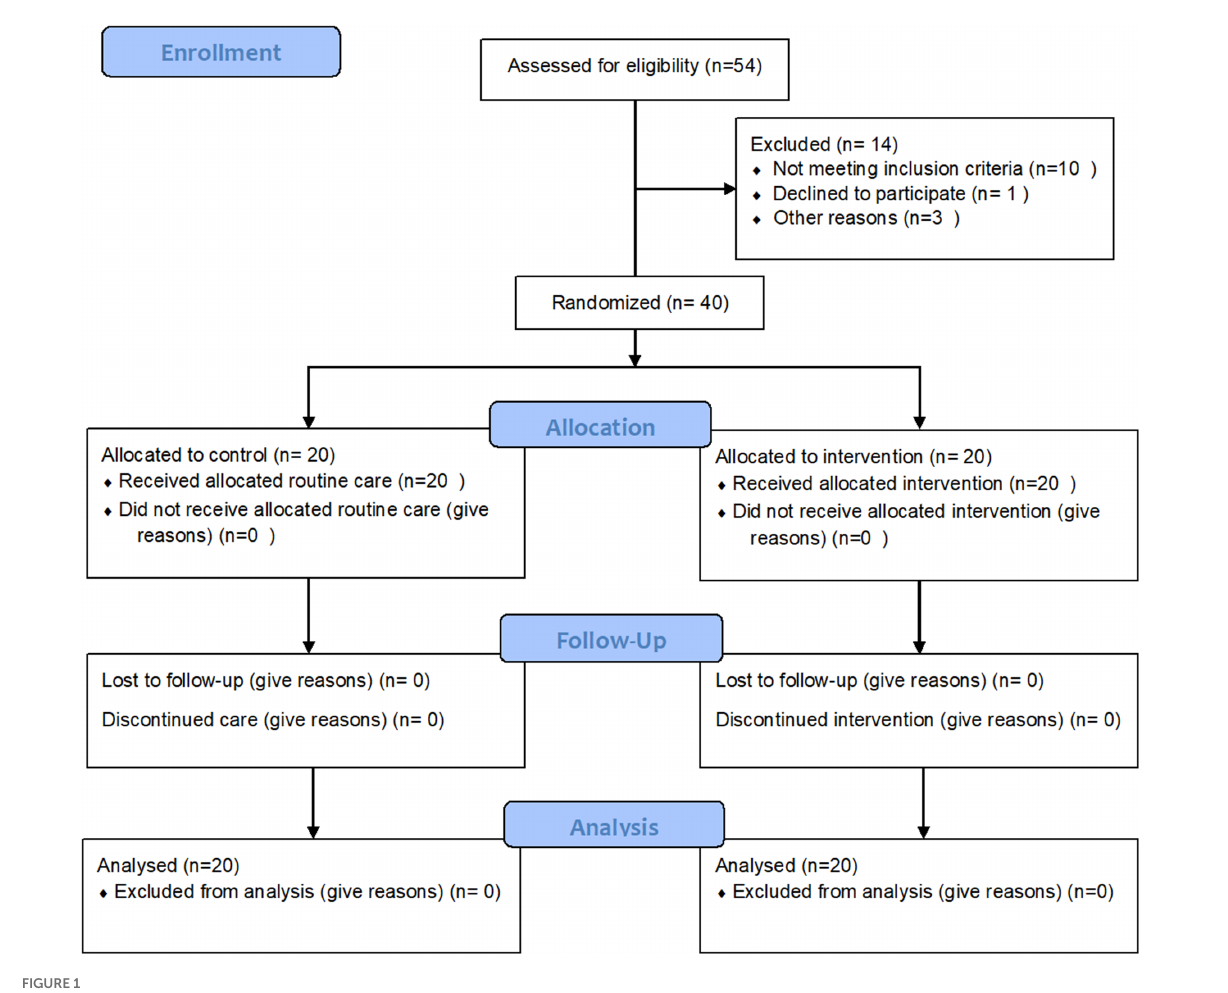
FIGURE 1 The process of